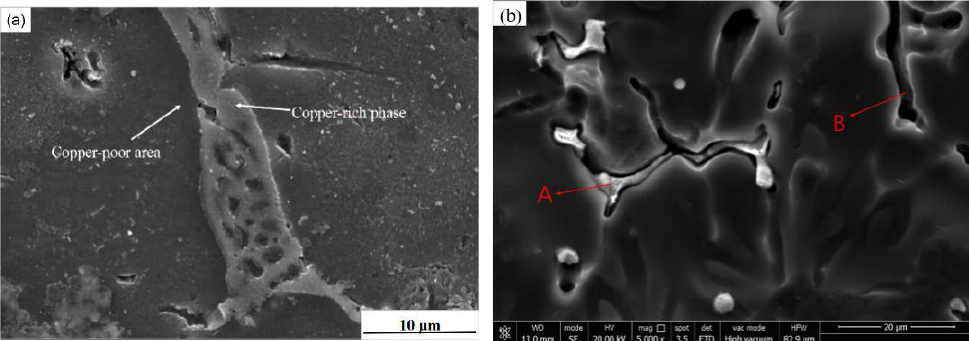
Figure 6. Micro-morphology of ZL205 and the surface morphology of the alloy after 30 days of corrosion after the addition of the refiner. ( a ) ZL205 alloy; ( b ) morphology after 30 days of corrosion in 3.5% NaCl.